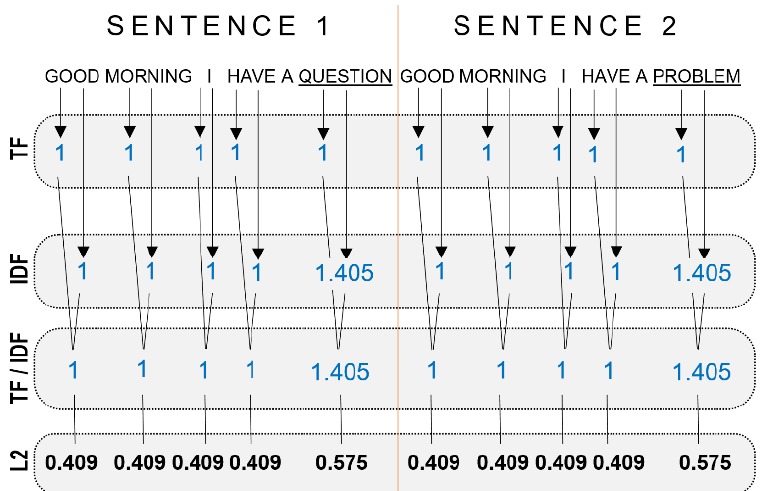
Figure 2. The vectorization technique used in the proposed approach. LEGEND: TF — term frequency; IDF — inverse document frequency; L2 — normalization.